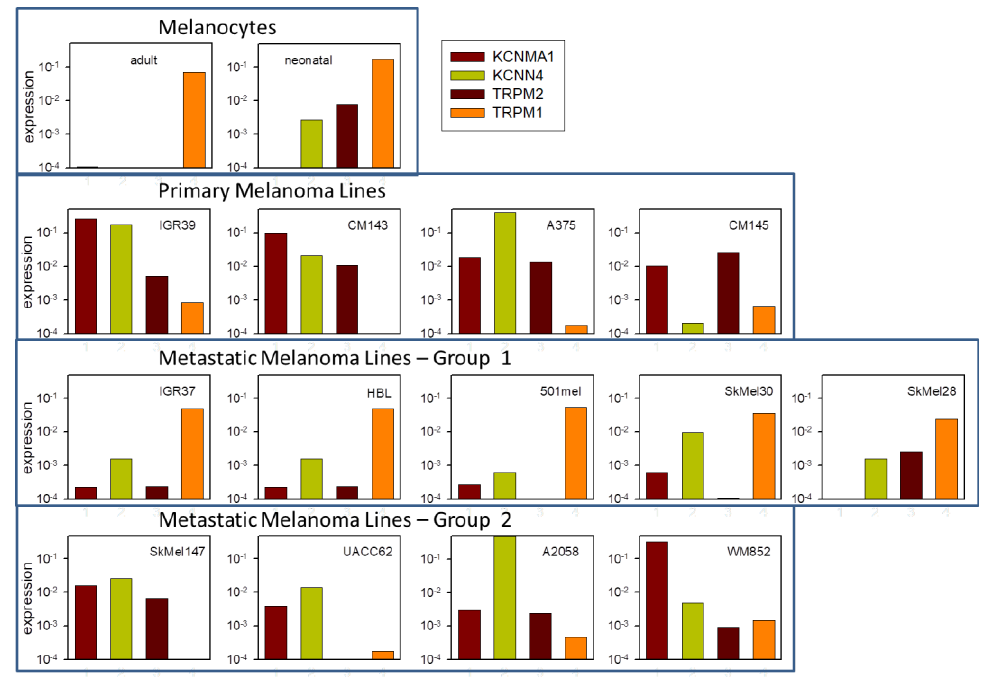
Figure 11. Expression analysis of selected ion channel genes in melanoma. Expression of the KCNMA1 , KCNN4 , TRPM2 , and TRPM1 genes in the indicated cell lines, as described in the Materials and Methods section.